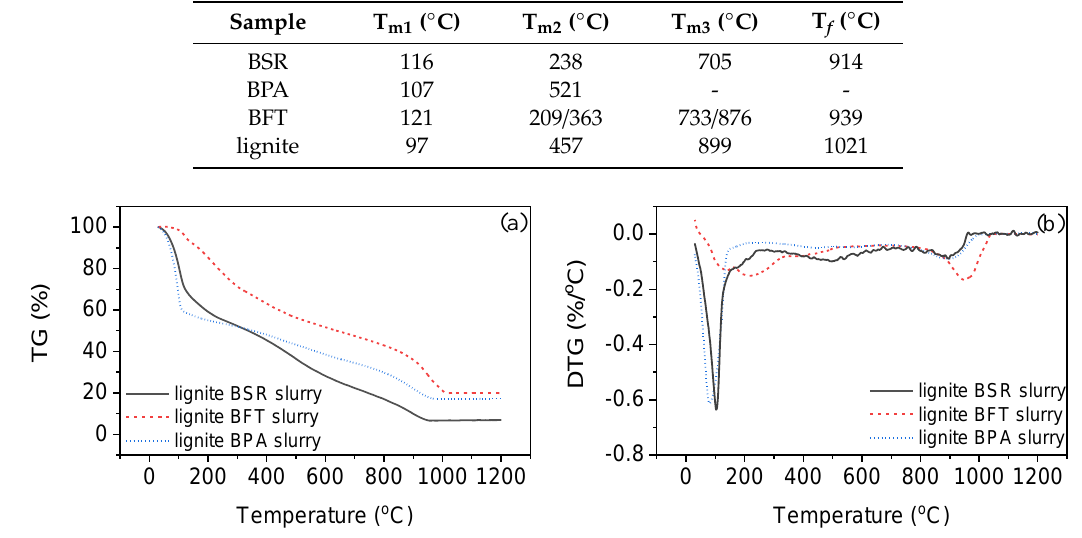
Figure 8. ( a ) TG curves of gasification of coals; ( b ) DTG curves of gasification of bio-oils.